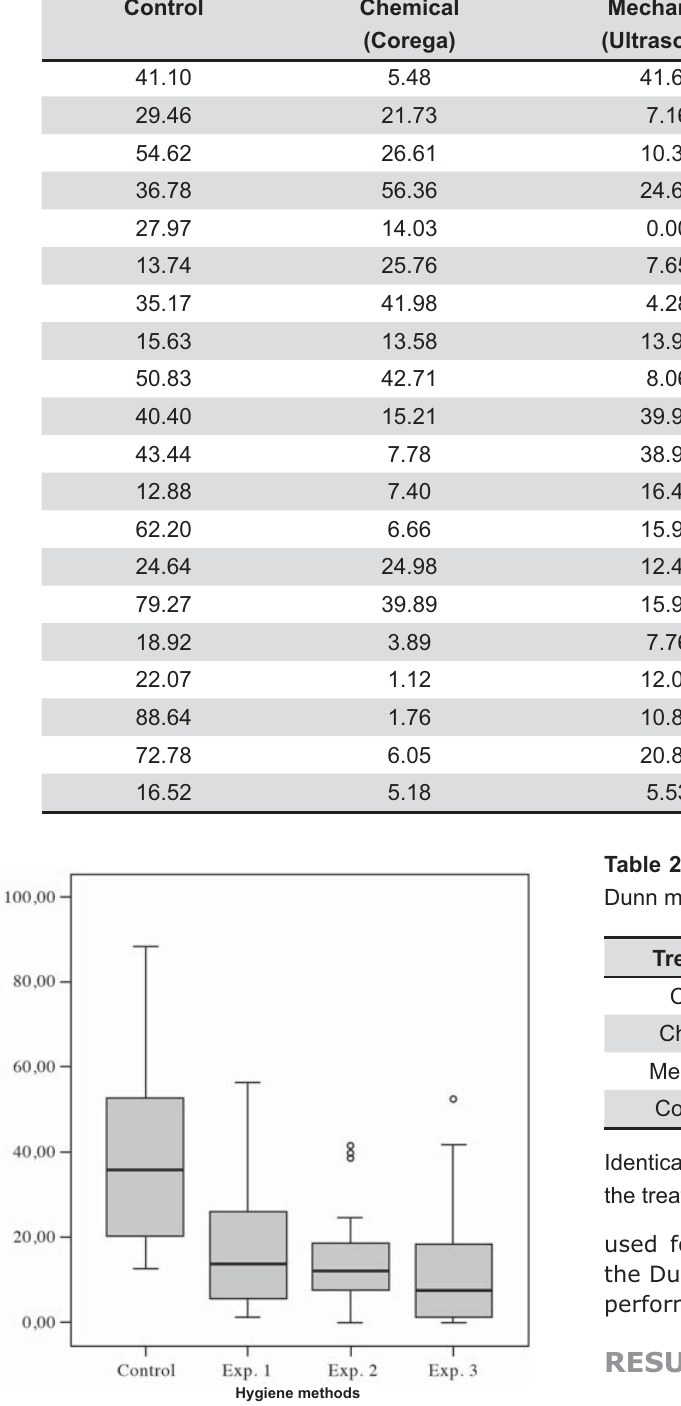
Figure 2- (cid:2)(cid:27)(cid:15)(cid:12)(cid:16)(cid:17)(cid:18)(cid:2)(cid:6)(cid:12)(cid:28)(cid:4)(cid:5)(cid:9)(cid:10)(cid:4)(cid:2)(cid:9)(cid:5)(cid:4)(cid:9)(cid:2)(cid:13)(cid:12)(cid:5)(cid:2)(cid:4)(cid:9)(cid:6)(cid:19)(cid:2)(cid:10)(cid:5)(cid:12)(cid:20)(cid:29)(cid:2)(cid:13)(cid:12)(cid:17)(cid:17)(cid:12)(cid:26)(cid:15)(cid:7)(cid:10)(cid:2) treatment (Exp. =